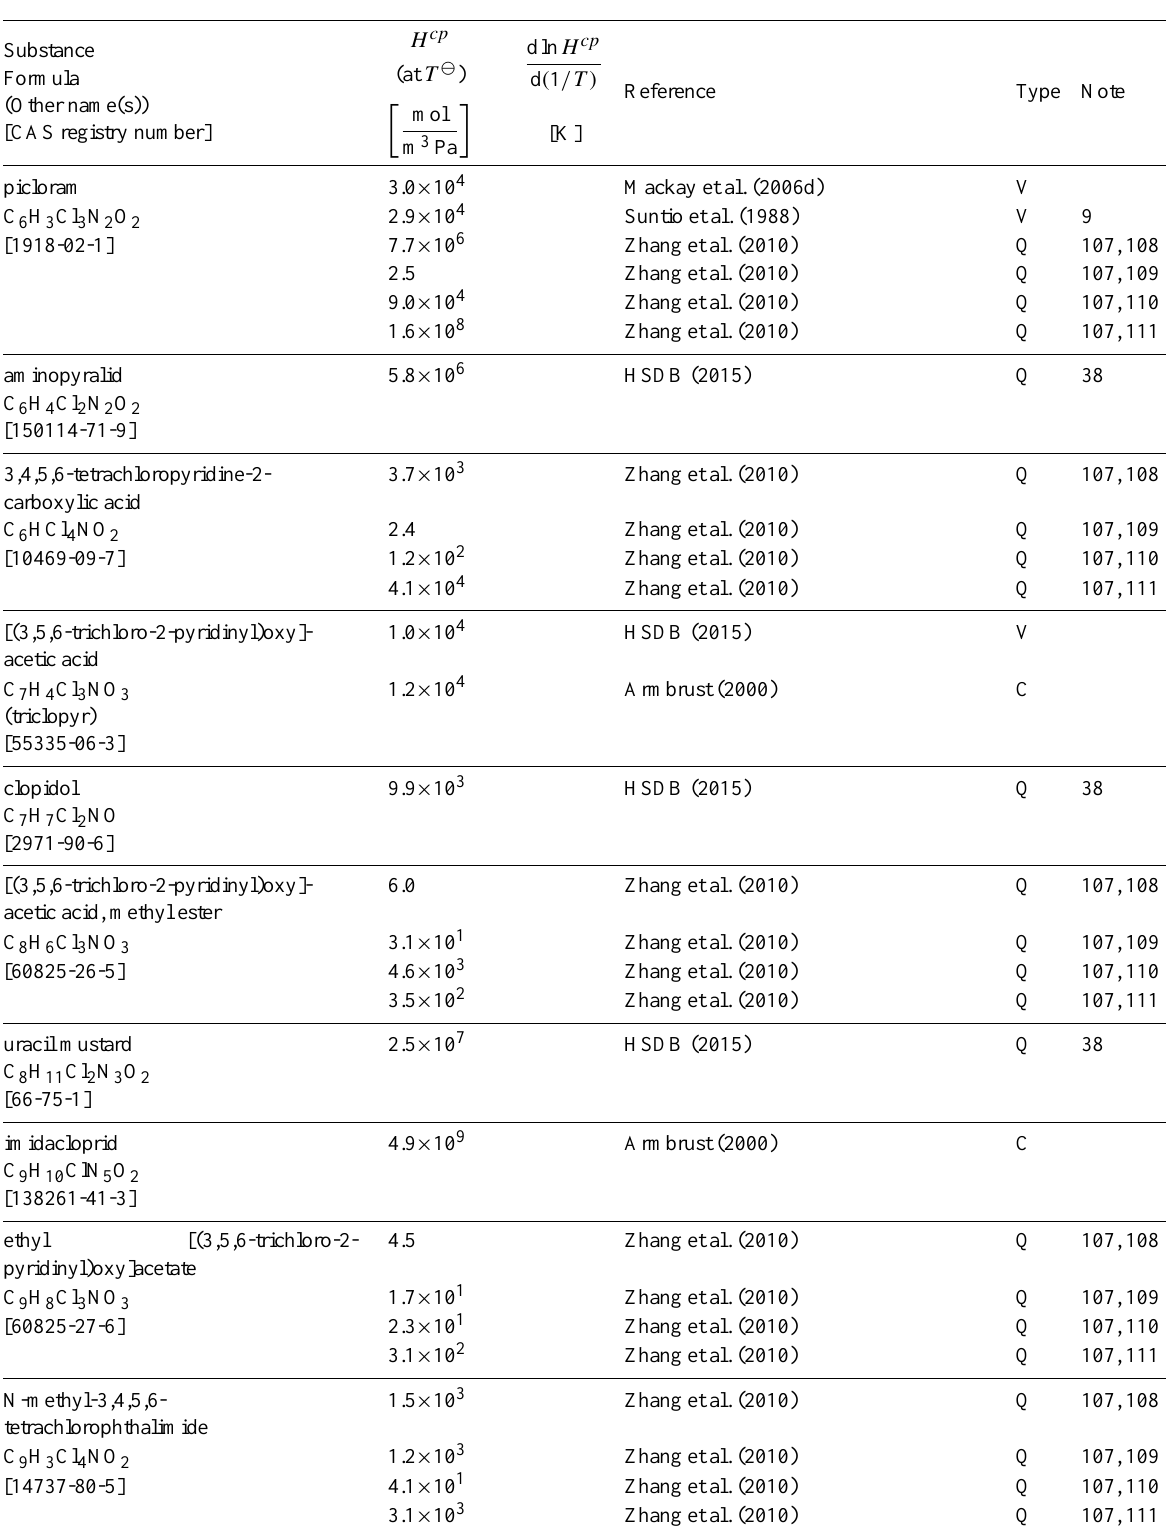
Table 6: Henry’s law constants for water as solvent